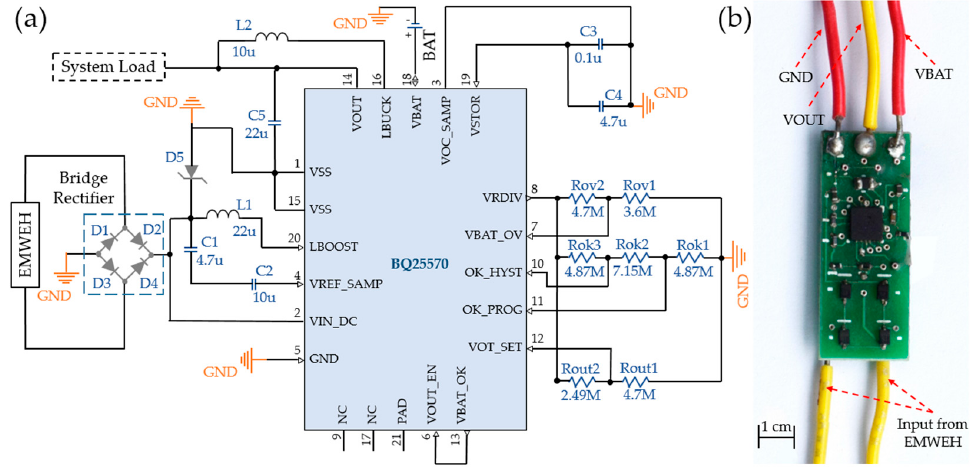
Figure 7. ( a ) Circuit diagram and ( b ) a photograph of a custom power management circuit